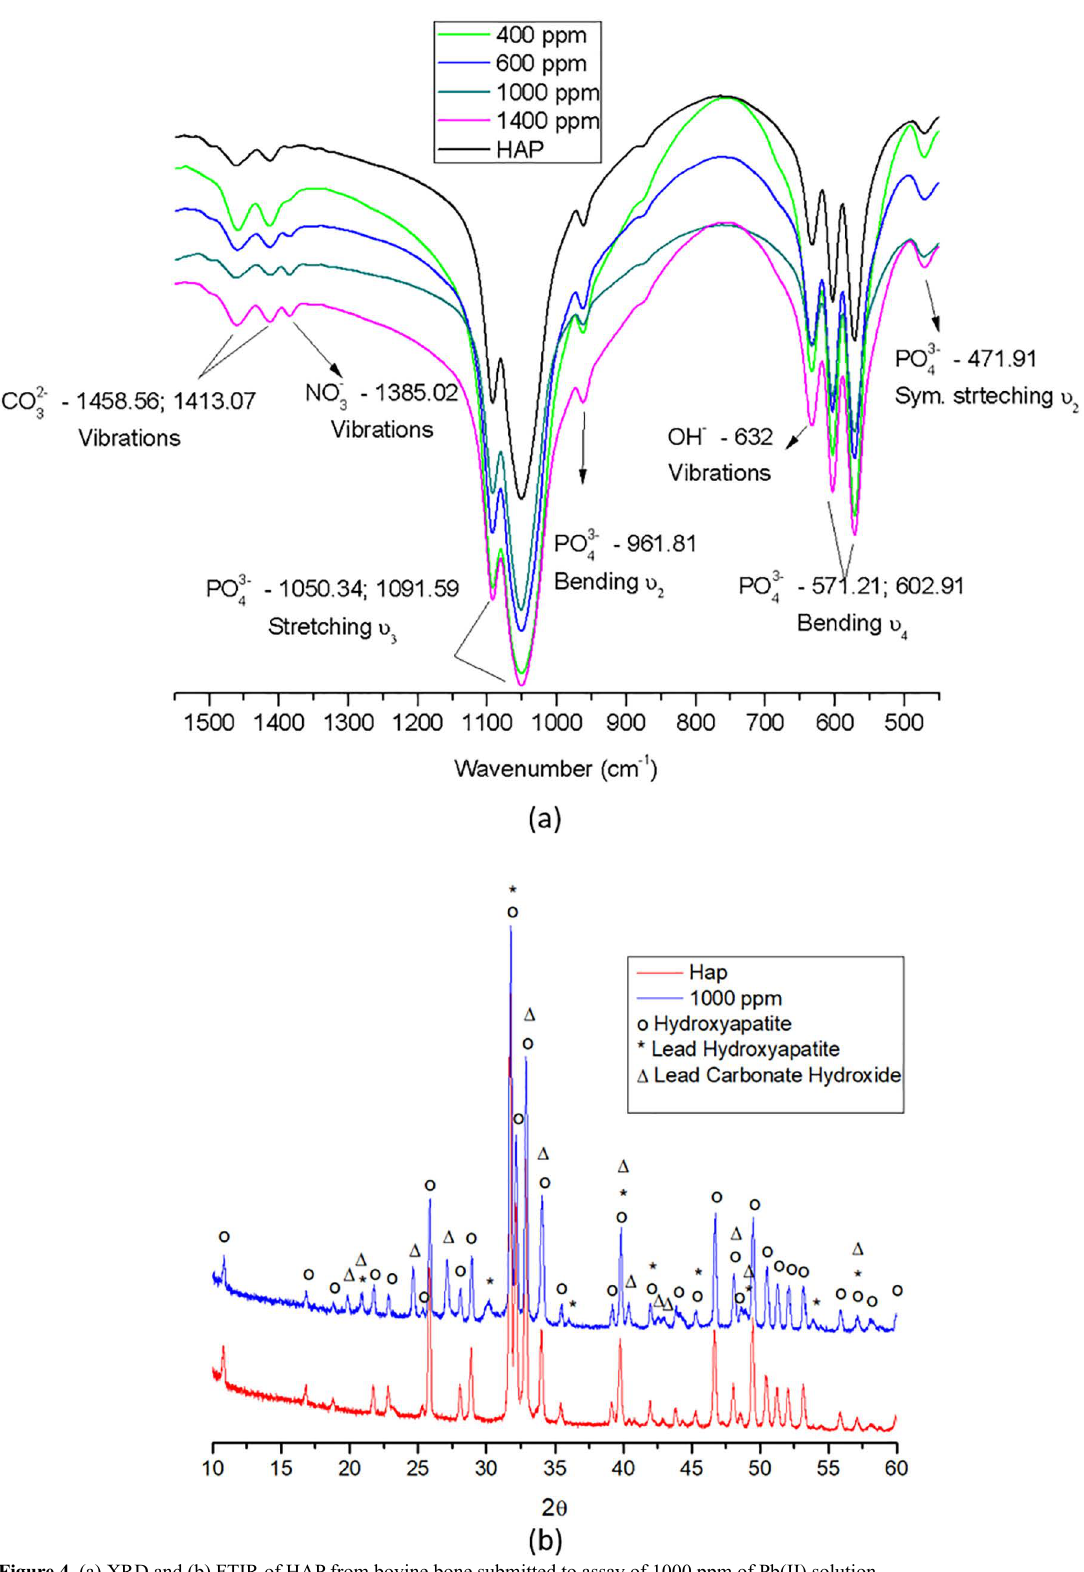
Figure 4. (a) XRD and (b) FTIR of HAP from bovine bone submitted to assay of 1000 ppm of Pb(II)